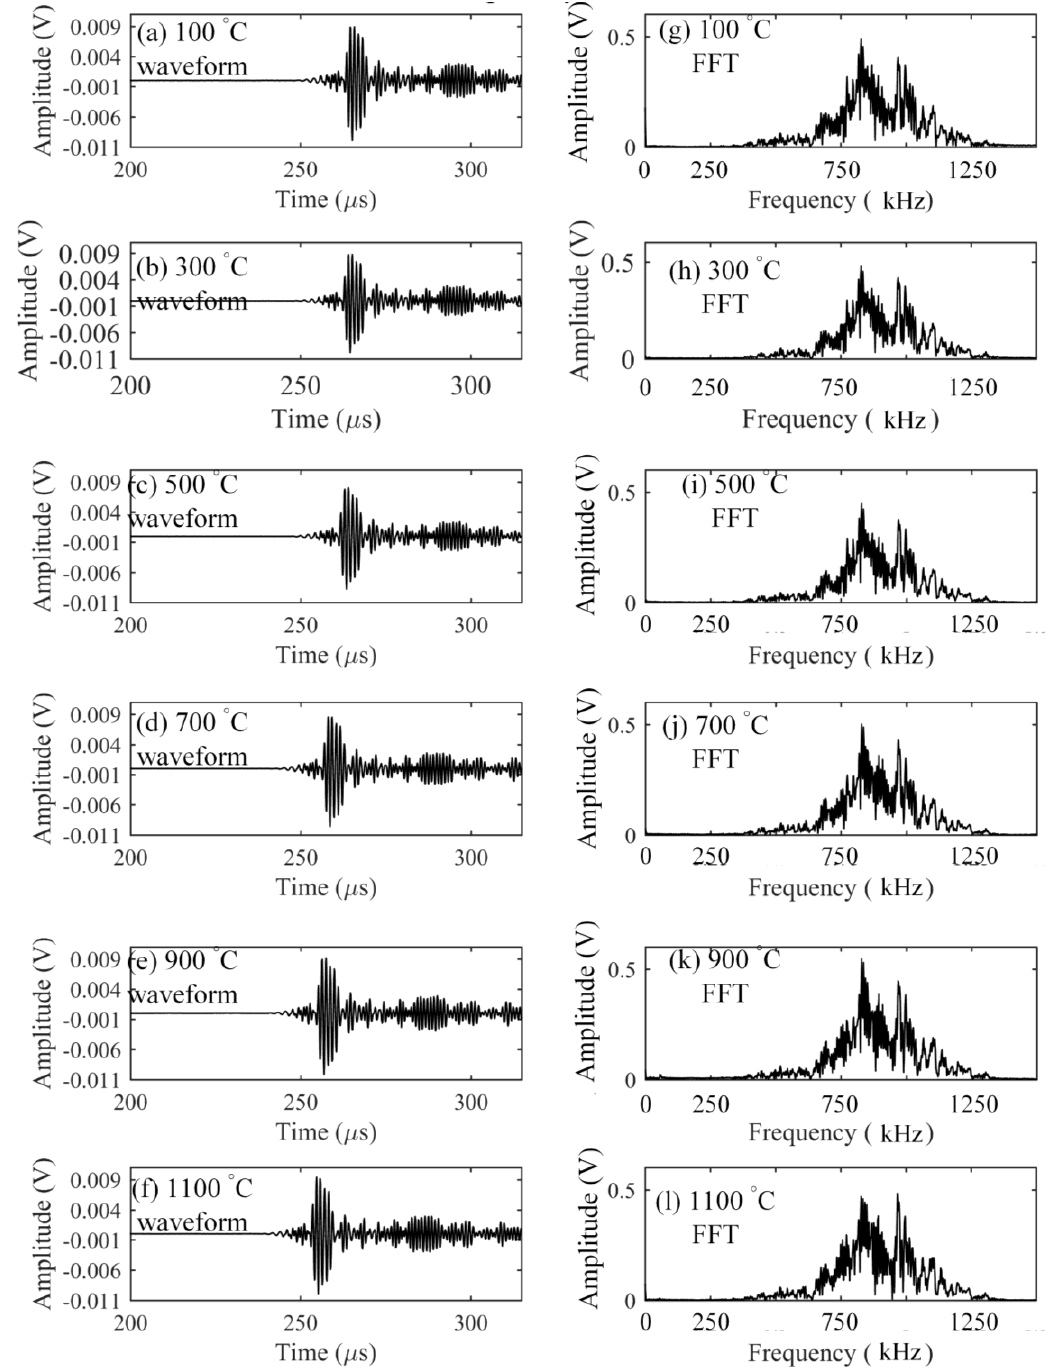
Figure 6. Responses to an ultrasonic wave with a center frequency of 900 kHz.